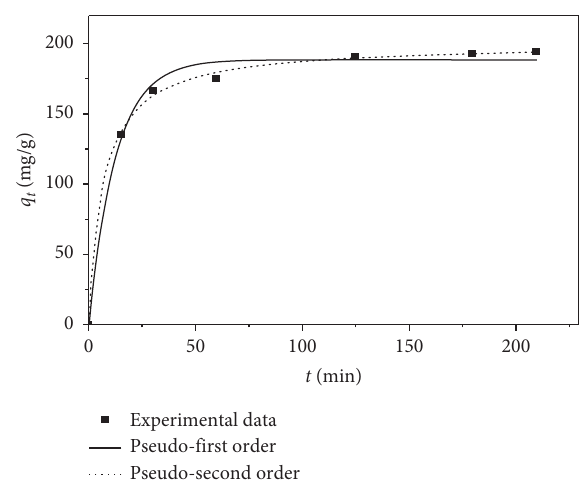
Figure 2: Nonlinear fits of pseudo-first-order and pseudo- second-order kinetics for MO adsorption onto activated